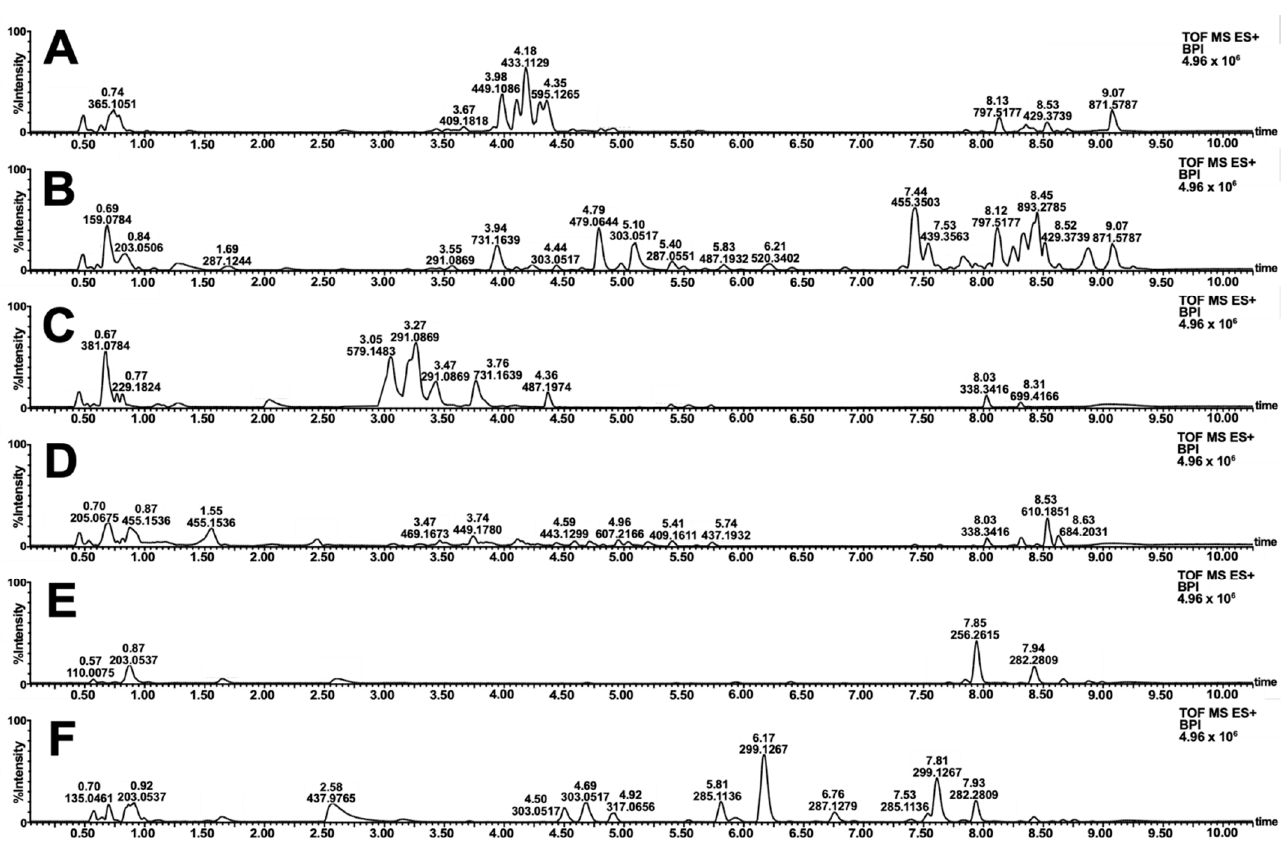
Figure 4. Base peak ion (BPI) chromatogram of extracted natural dyes. Full-scan profiles in the positive mode are shown for decoctions of T. catappa leaf ( A ) D. philippinensis fruit peel ( B ), E. deglupta bark ( C ), D. discolor ( D ), S. malaccense ( E ), and S. samarangense ( F ) fruit peels.